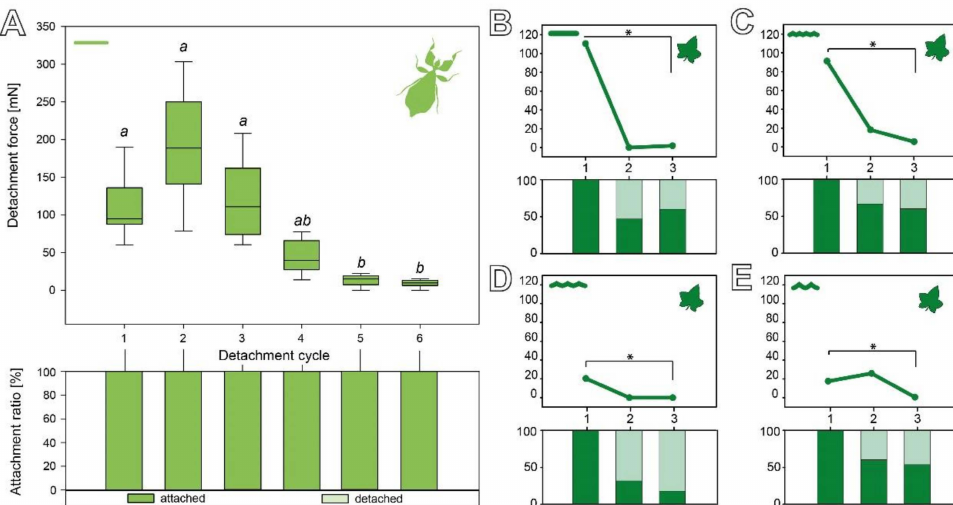
Figure 6. Sequential detachment force measurements. ( A ) P. philippinicum eggs. Line plot (above) and the corresponding count of attached and detached eggs (attachment ratio, below) for sequential repetitions ( N = 8). Boxes indicate the 25th and 75th percentiles, the line represents the median, and the whiskers are the 10th and 90th percentiles. Lowercase letters indicate statistical similarity: boxes with the same letters are not statistically different (Friedman repeated-measures ANOVA on ranks, Tukey’s post hoc test, p < 0.05). ( B – E ) Detachment force of C. grandis seeds during repetitive detachments on different substrates ( N = 15 per substrate). Line plots (above) and the corresponding attachment ratio (below) for sequential measurements; dots represent the median. ( B ) 0 µ m. ( C ) 1 µ m. ( D ) 12 µ m. ( E ) 440 µ m. * p ≤ 0.05 (Friedman repeated-measures ANOVA on ranks or